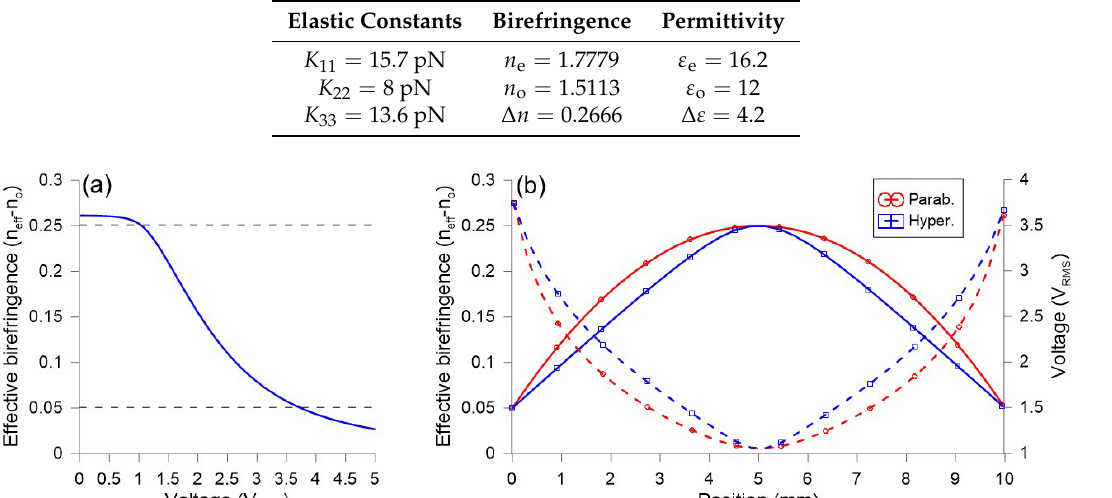
Table 1. Parameters for the nematic LC MDA-98-102.